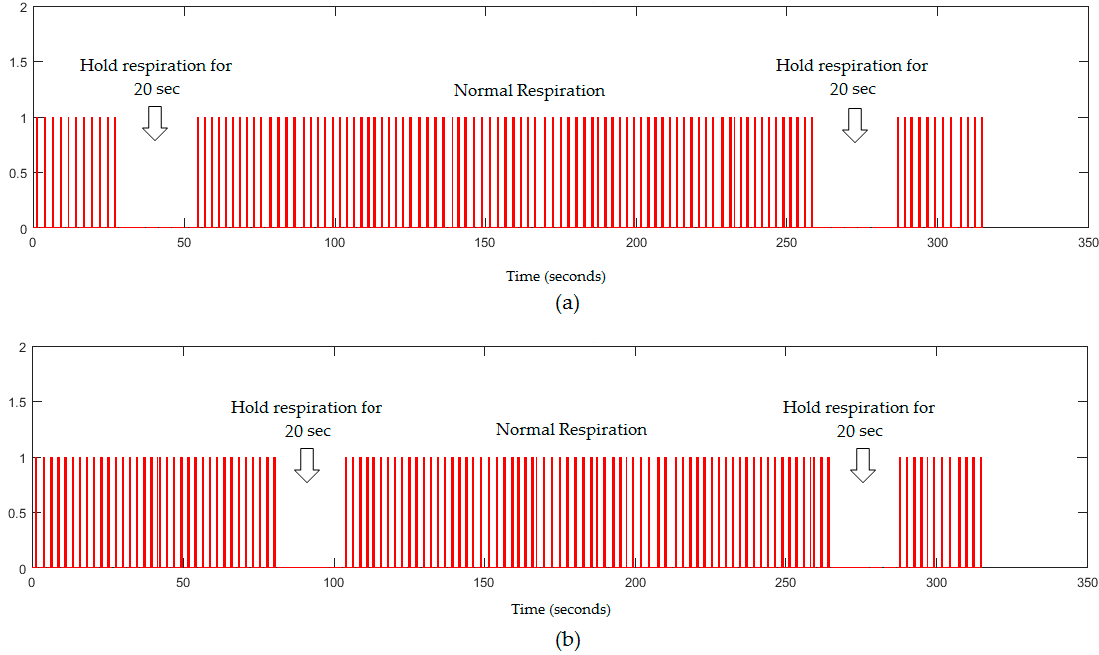
Figure 11. The respiratory signals (5 min) obtained from the proposed system in a dark environment, ( a ) without a blanket; ( b ) with a blanket.